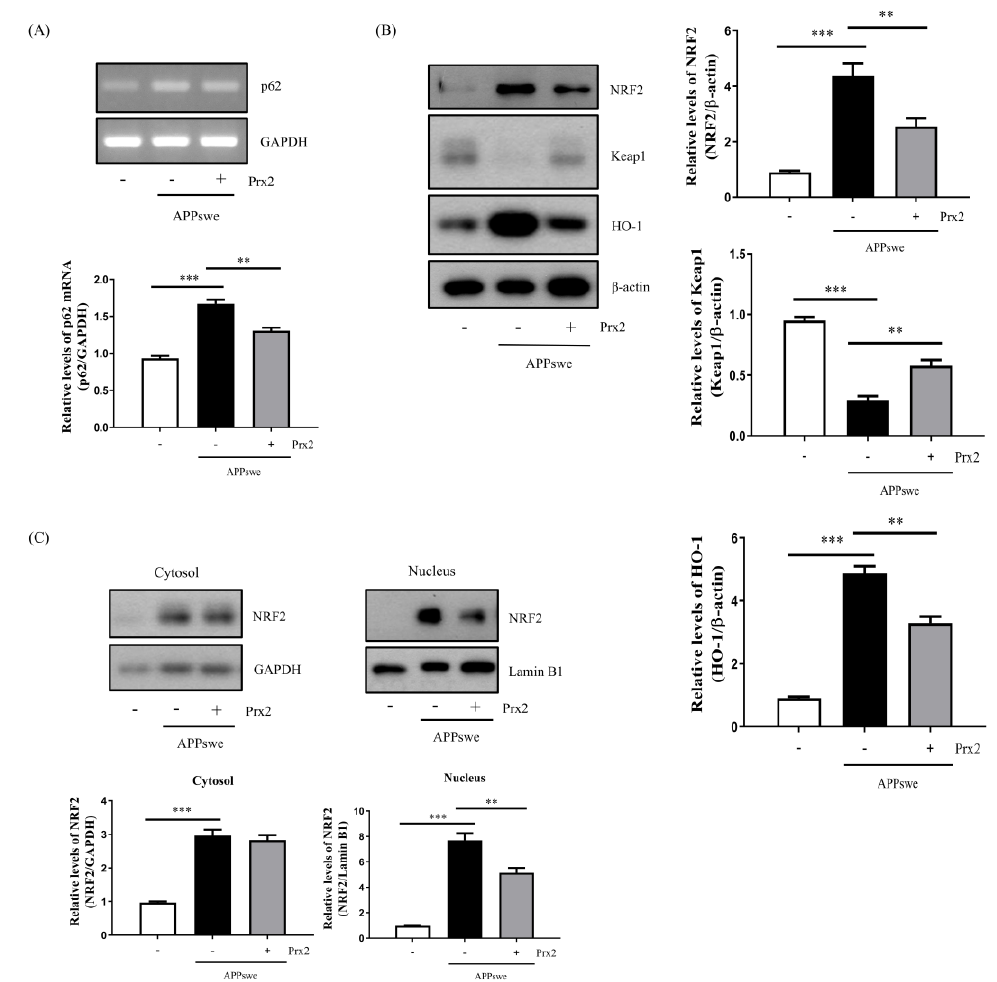
Figure 5. Prx2 overexpression decreased autophagy via the ROS – NRF2 – p62 pathway in N2a-APPswe cells. ( A ) The p62 mRNA levels were analyzed using RT-PCR in N2a, N2a-APPswe, and N2a-APPswe-Prx2 cells cultured for 24 h. ( B , C ) Western blot analysis of NRF2, Keap1, and HO-1 in the whole cell lysate, nucleus, or cytosol of N2a, N2a-APPswe, and N2a-APPswe-Prx2 cells cultured for 24 h. Data are represented as the means ± SEMs of three independent experiments (** p < 0.01, and *** p < 0.001).